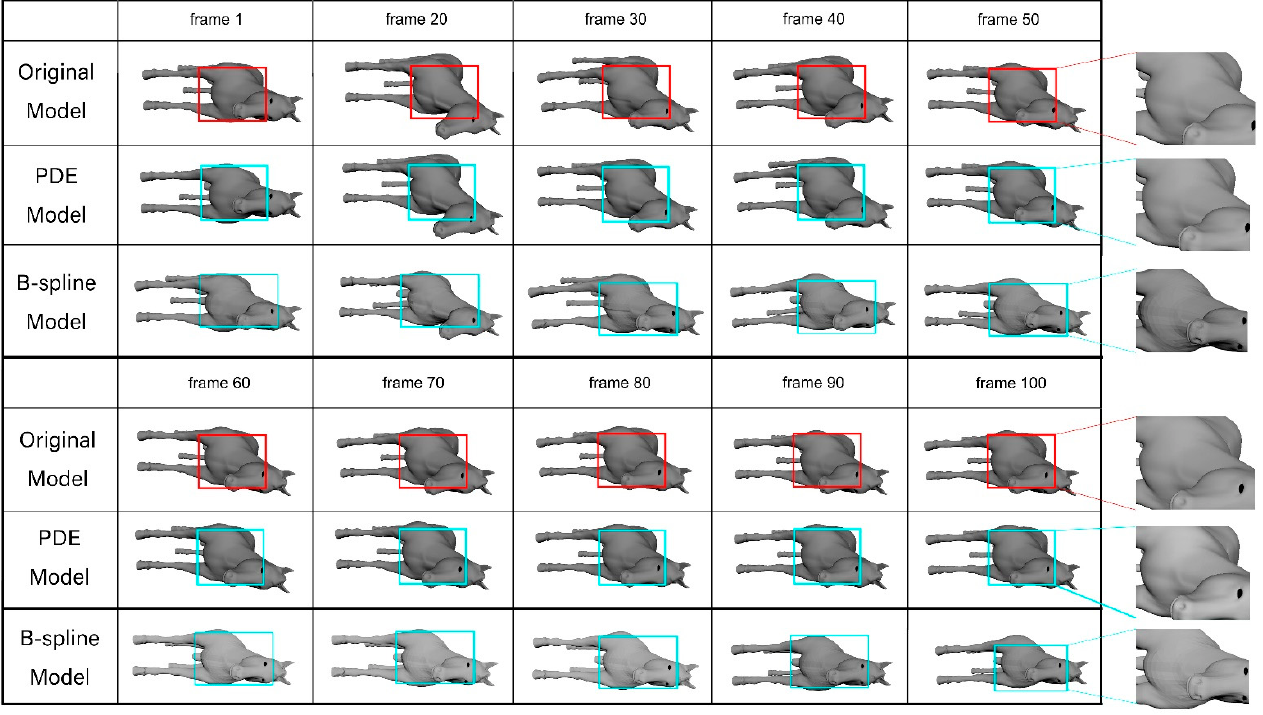
Figure 6. Original deformed shapes and reconstructed shapes of a horse model at keyframes 1, 20, 30, 40, 50, 60, 70, 80, 90, and 100.